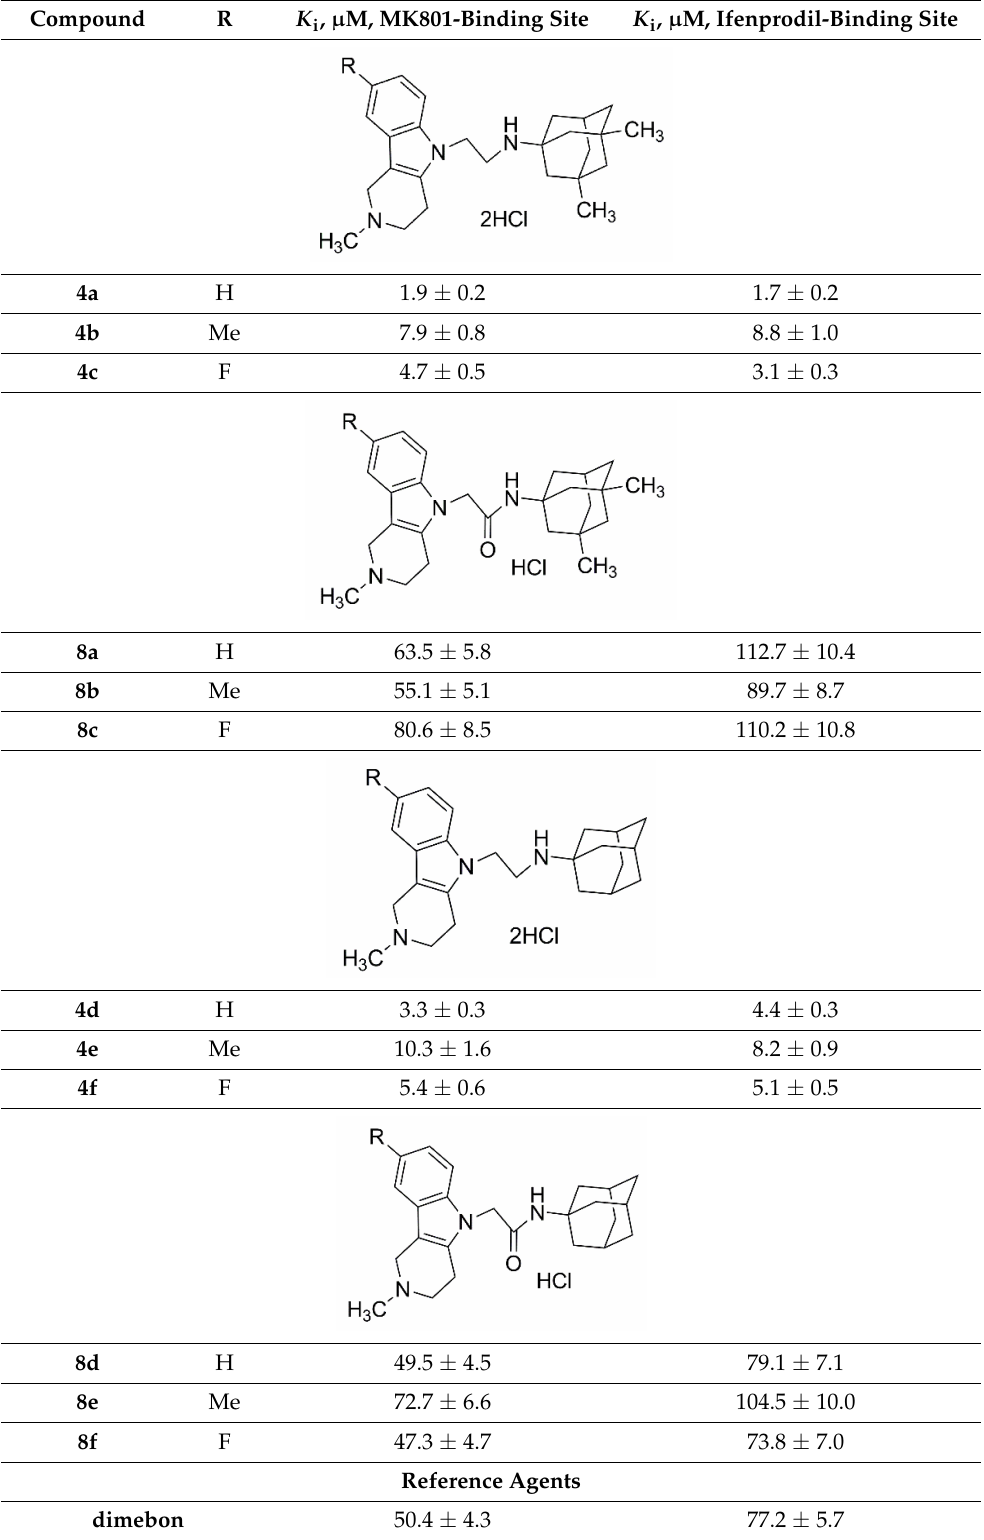
Table 1. Binding of compounds to MK-801-specific and Ifenprodil-specific sites of NMDA